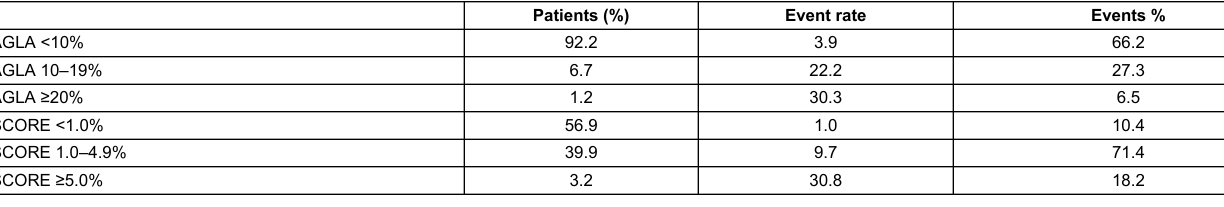
Table 8: Distribution of patients and events across risk categories of AGLA and